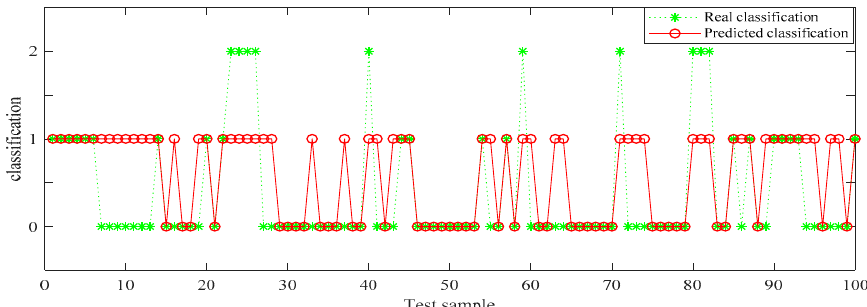
Figure 6. BP (back propagation) neural network recognition results from dataset 1.